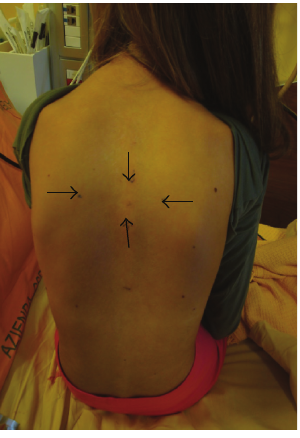
Figure 3: Patient’s painful